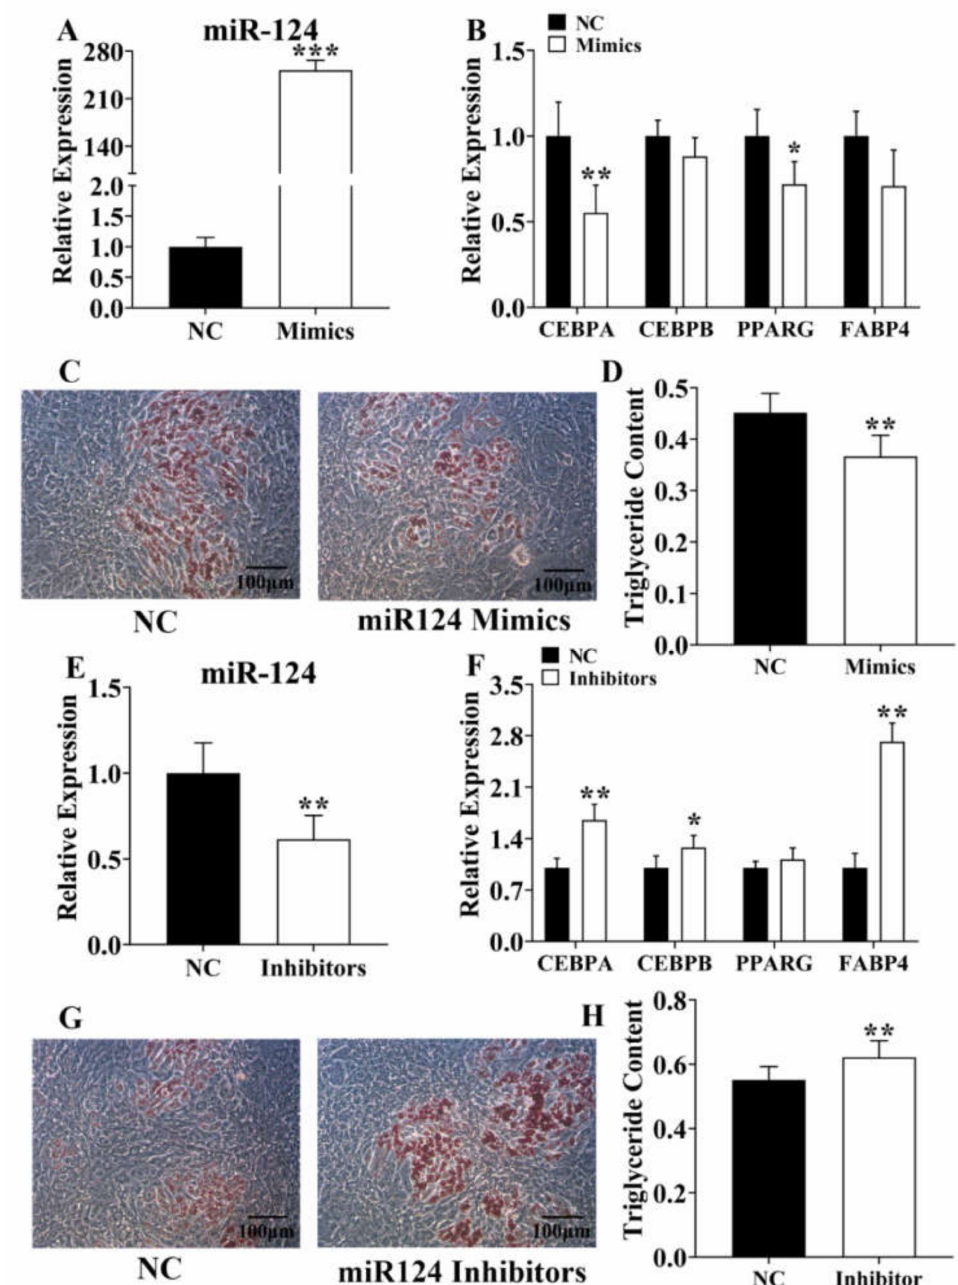
Figure 5. Ssc-miR-124 inhibited pre-adipocyte adipogenesis. ( A ) Ssc-miR-124 was overexpressed in pre-adipocyte by transfecting ssc-miR-124 mimics. ( B ) The real-time analysis of adipogenic marker genes in pre-adipocyte after transfecting ssc-miR-124 mimics for 48 h. ( C , D ) The pre-adipocytes oil red O staining ( C ) and quantitation of total triglyceride result ( D ) after transfecting ssc-miR-124 mimics. ( E ) Ssc-miR-124 was inhibited in pre-adipocyte after transfecting ssc-miR-124 inhibitors. ( F ) The real-time analysis of adipogenic marker genes after transfecting ssc-miR-124 inhibitors for 48 h. ( G , H ) The pre-adipocyte oil red O staining ( G ) and quantitation of total triglyceride result ( H ) after transfecting ssc-miR-124 inhibitors. Data are presented as mean ± s.e.m. * means P < 0.05, ** means P < 0.01, and *** means P <